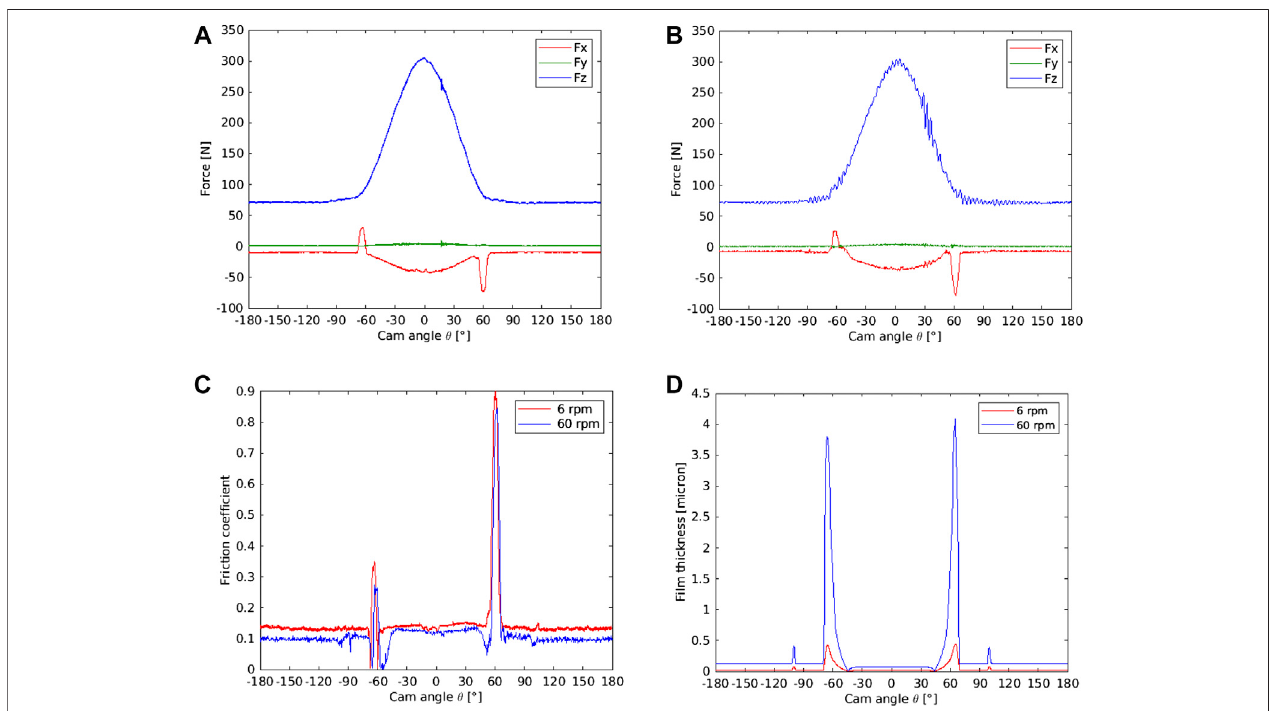
FIGURE 11 | Spline cam. Force components measured during a cycle at 6 rpm (A) and 60 rpm (B) . Friction coef fi cient (C) and calculated minimum fi lm thickness (D) at 6 and 60 rpm.